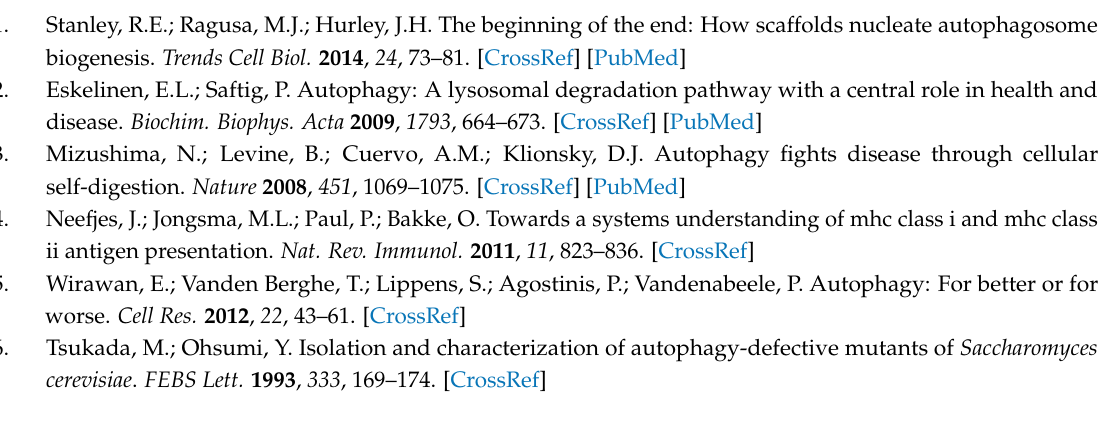
Table 5. Summary of the analyzed cellular processes in AX2, ATG12 − , ATG16 − , and ATG12 − /16 − cells. Plus signs indicate an increase and minus signs a decrease in the corresponding cellular processes in comparison to AX2 cells. An increase in the number of plus or minus signs correlates with the severity of the respective defect. Strains Type Cellular Process ATG12 − ATG16 − ATG12 − /16 − Development − − − Autolysosome formation − − − (i) Cell viability − − − Growth in shaking culture − − − − − Macropinocytosis − − − − − (ii) Proteasomal activity − − − − − Spore viability − − − − − − Maximal cell titre − − − − − − (iii) Phagocytosis of yeast − − − − (iv) Growth on K. aerogenes − + + +/ −